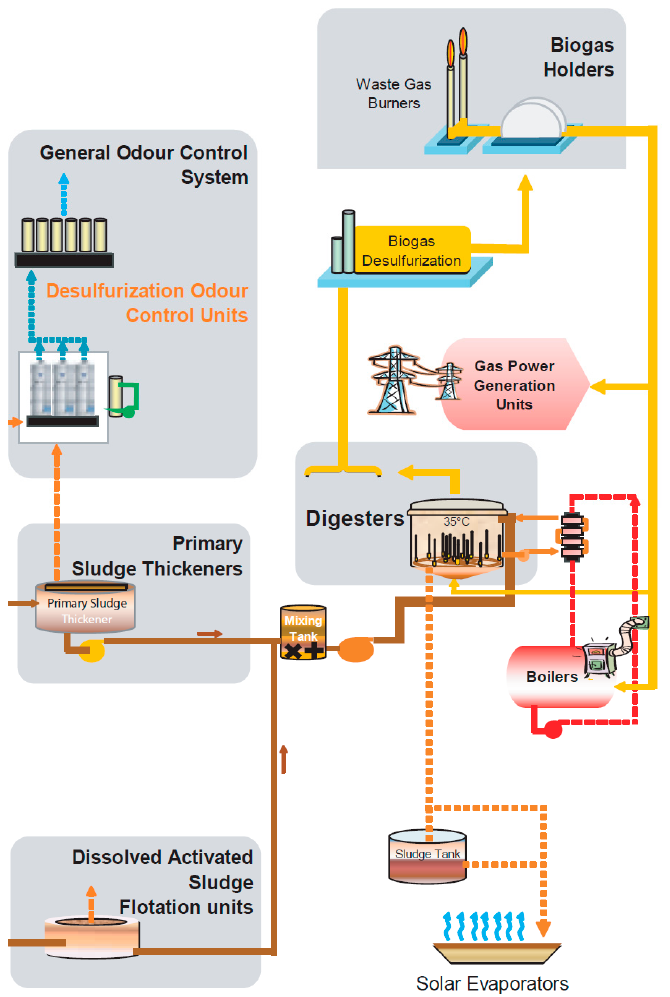
Figure 10. Biogas production in anaerobic digesters at the Al Samra WWTP [62].